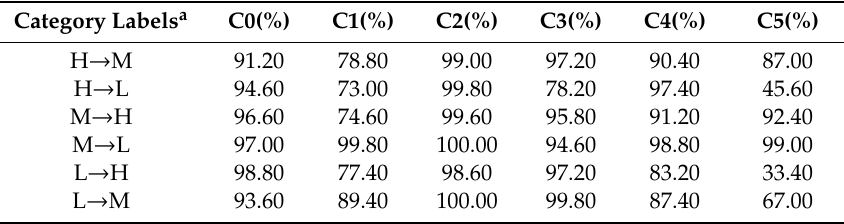
Table 4. Recall of the proposed GTL